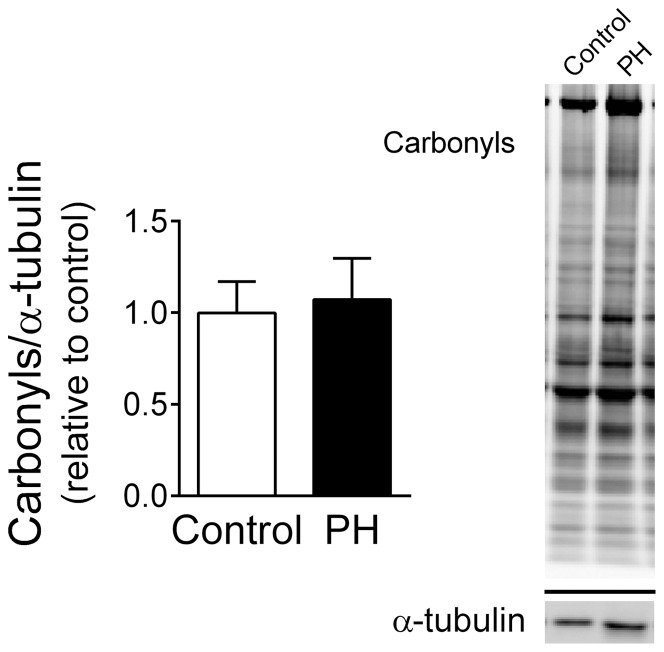
Protein carbonyls are unchanged in diaphragm from PH mice.These findings suggest that PH does not increase protein oxidation in mouse diaphragm. Total protein carbonyls are normalized to corresponding α-tubulin and expressed relative to the mean for the control group (n = 4/group). Image shows membranes probed for protein carbonyls and α-tubulin. Lanes are examples of control and PH diaphragm.